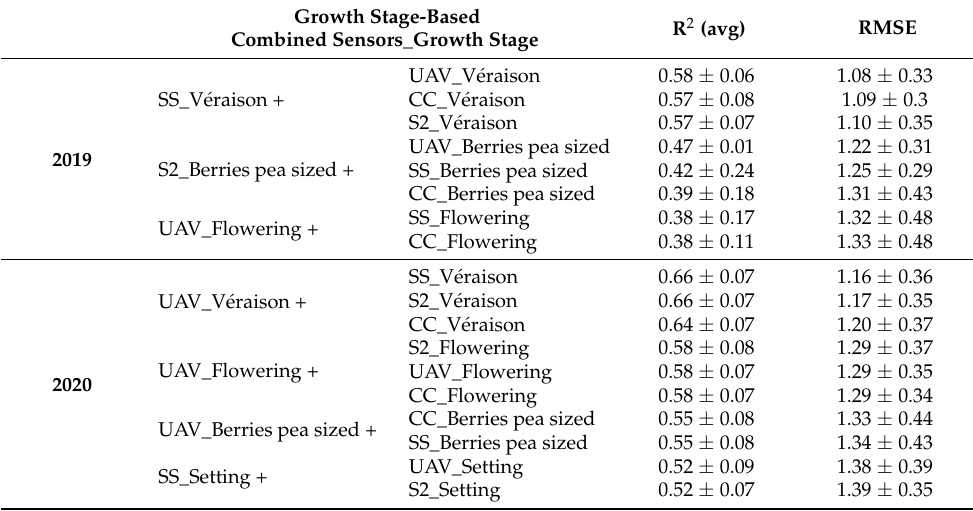
Table 5. Selected best performed growth stage-based R 2 per year for combined sensors and growth stages using AutoML to evaluate their performance in assessing the wine grapes quality characteris- tics (legend as for Table